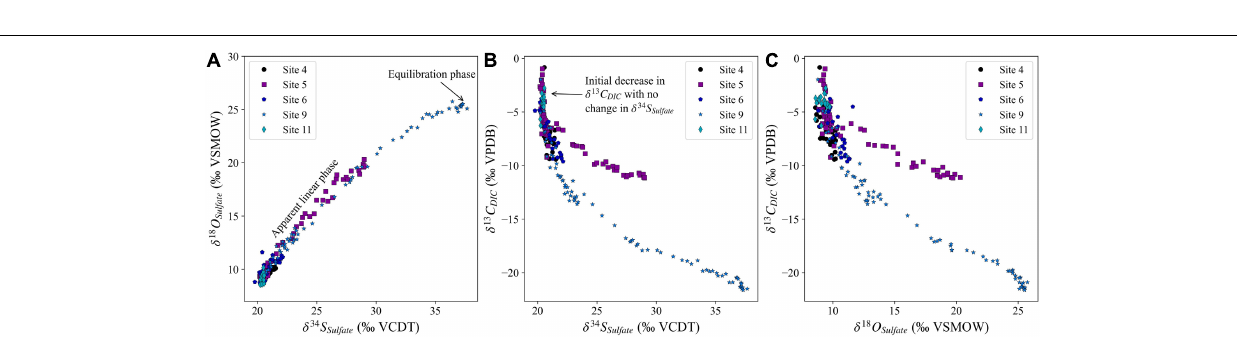
FIGURE 4 | Panel (A) displays the relative change in the sulfur and oxygen isotopic composition of pore fluid sulfate at all five sites. The change in the sulfur (B) and oxygen (C) isotopic composition of sulfate vs. the change in the carbon isotopic composition of dissolved inorganic carbon.